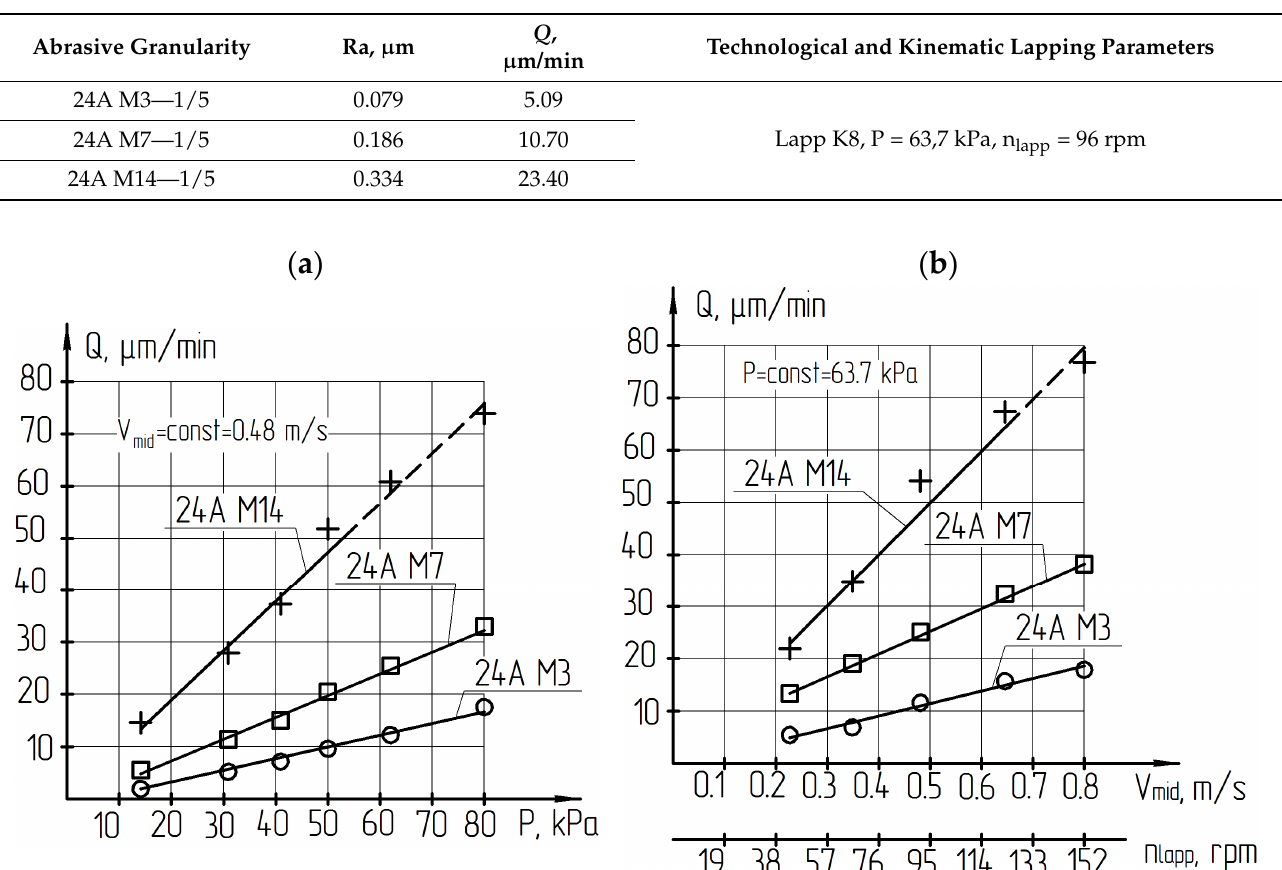
Table 2. Influence of abrasive granularity on the lapping process parameters.